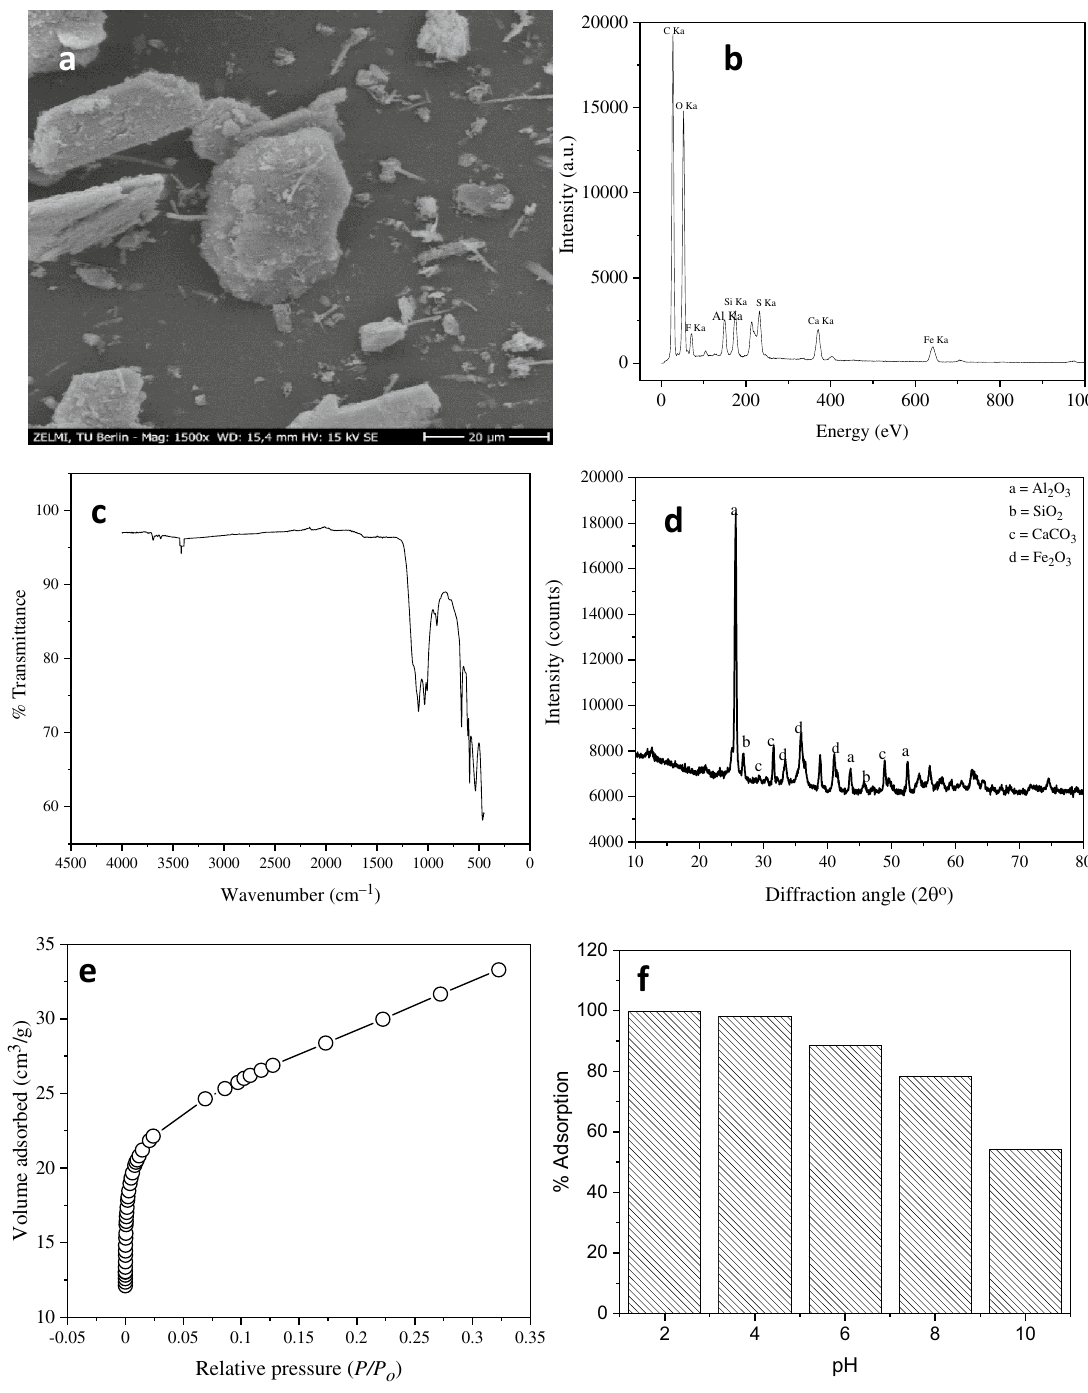
Figure 1. Characteristics of CHCFe; SEM micrograph ( a ), EDX spectrum ( b ), FTIR spectrum ( c ), XRD pattern ( d ), N 2 adsorption–desorption isotherm ( e ), and effect of pH on adsorption capacity of CHCFe ( f ). Conditions for ( f) : initial pH of the solution = 2–10; mass of adsorbent = 0.05 mg; temperature = 25 °C;agitation time = 4 h; initial concentration of Congo red = 2 g L –1 ; volume of Congo red = 20 mL; and agitation speed = 160